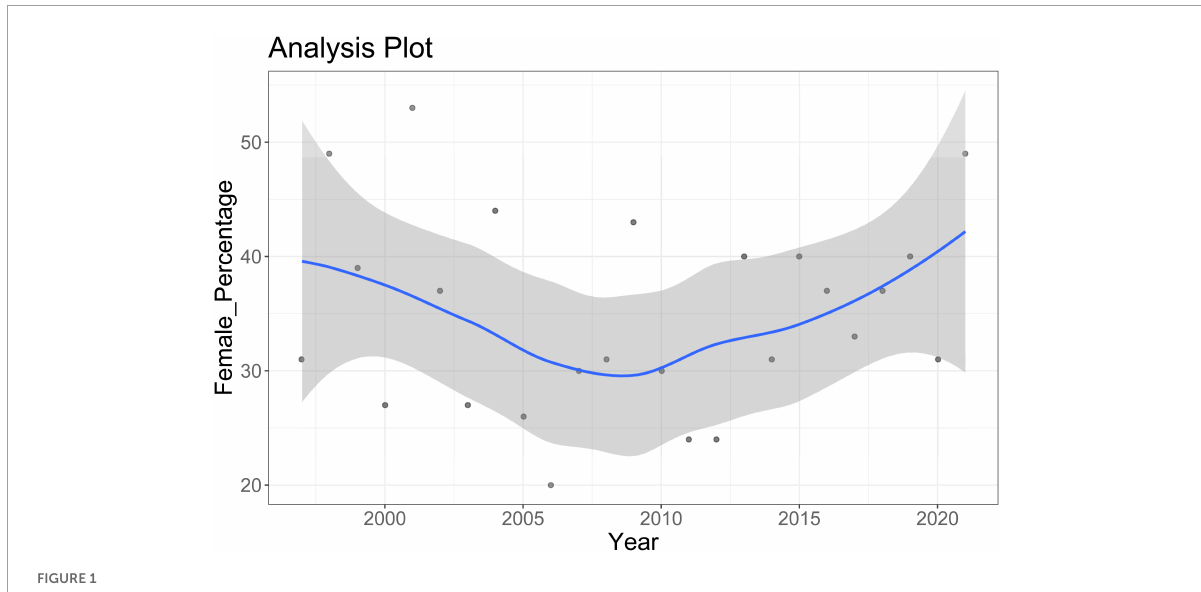
FIGURE1 The percentage of female first authors over time.